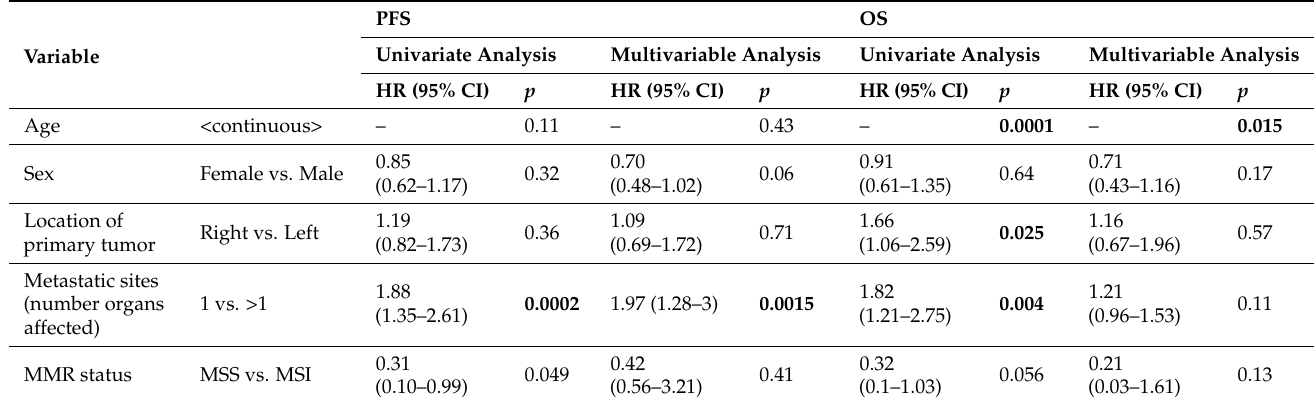
Table 2. Cox models for PFS/OS stratified by the annotated clinical